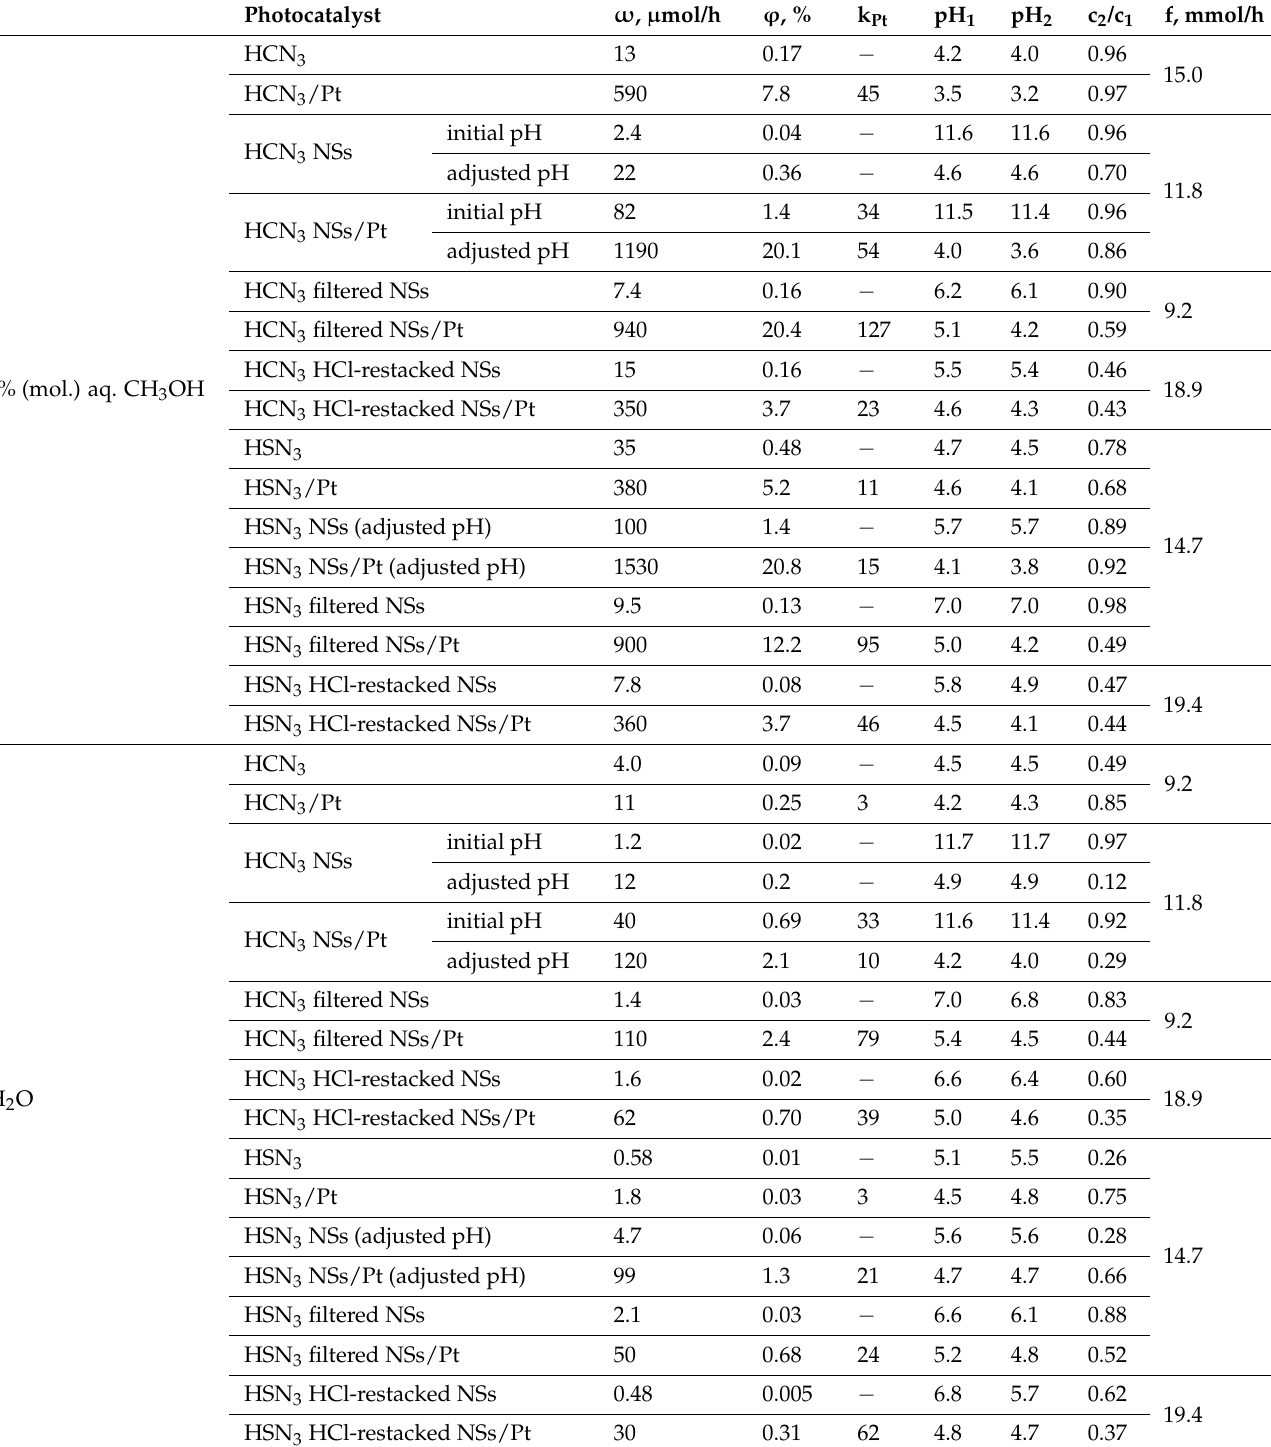
Table 2. Data on photocatalytic activity of protonated niobates and their nanosheets, pH (pH 1 — before, pH 2 —after photocatalytic experiment) and sedimentation stability of the reaction suspensions (c 2 /c 1 —ratio of volume photocatalyst concentrations at the ending and at the beginning of the photocatalytic experiment) as well as photon flux f in the photocatalysts’ absorption